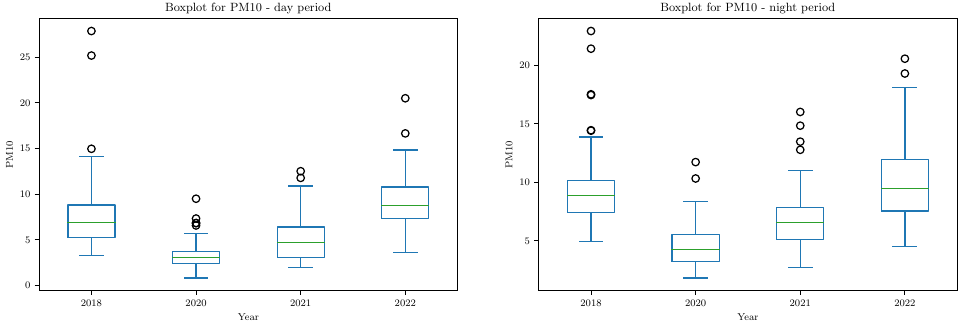
Figure 5. Boxplots for PM2.5 for daytime ( left ), and night-time ( right ) for the data in the observed period.